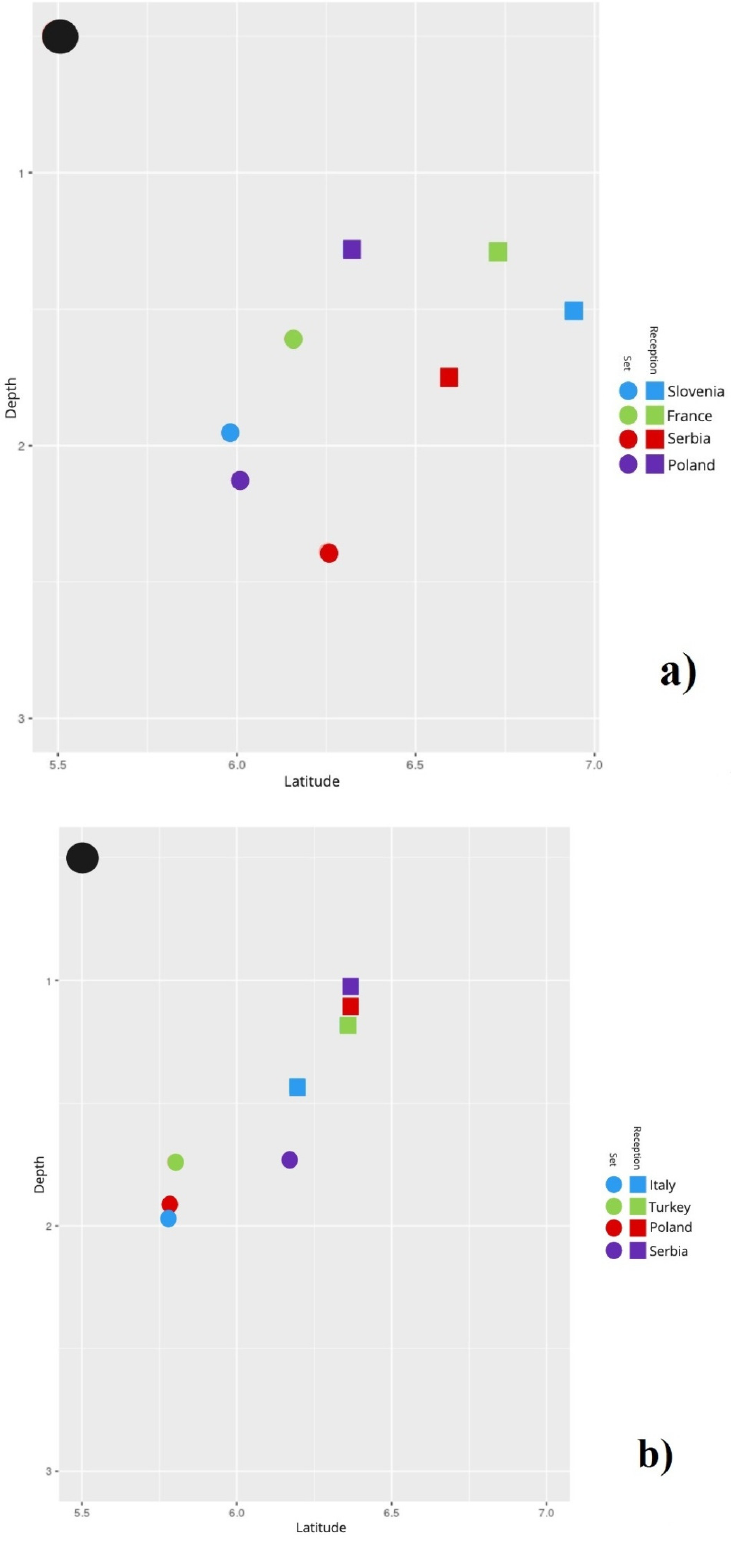
Figure 3. Average position of the setter in the moment of reception and average position of the setter in the moment of set of the male ( a ) and female ( b ) national teams.